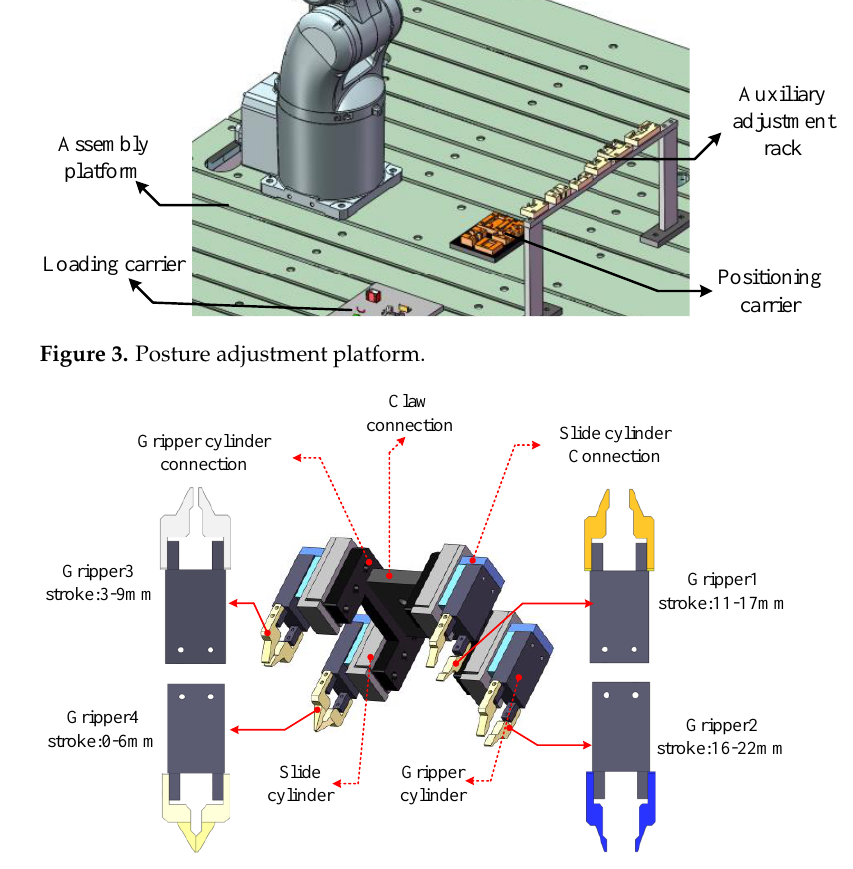
Figure 4. Robot flexible multi-gripper claw.